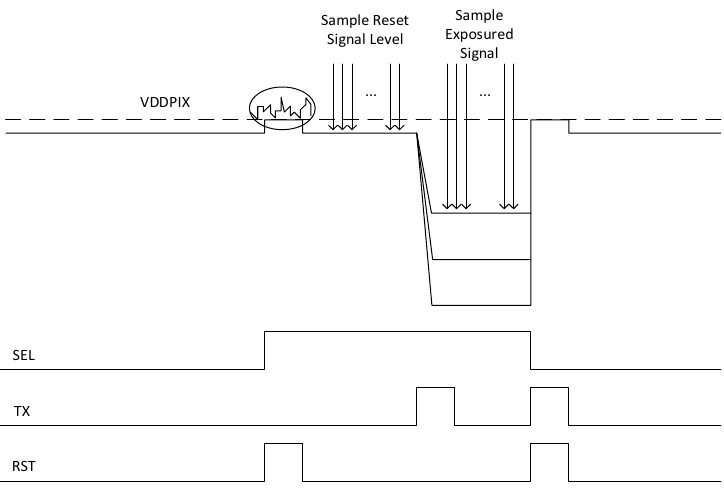
Figure 15. Simplified RS 4T-pinned pixel signaling with oversampling operation.